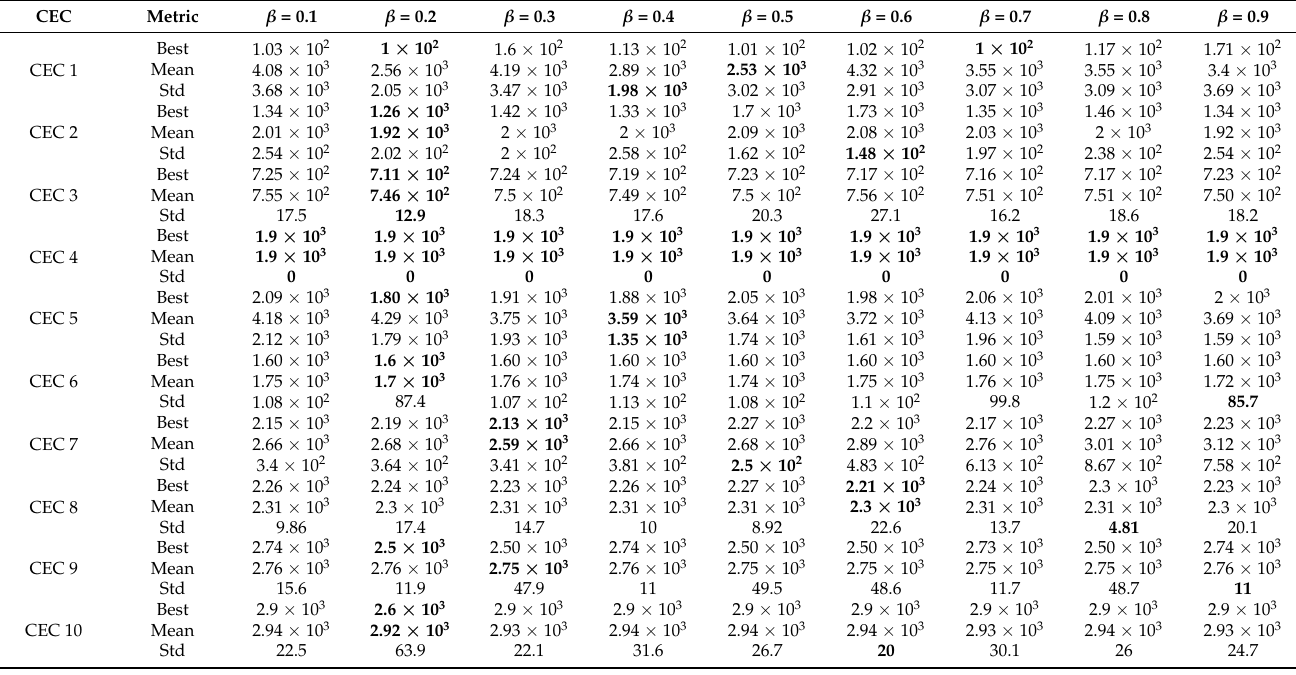
Table 10. Parameters sensitivity analysis. (Bold means good